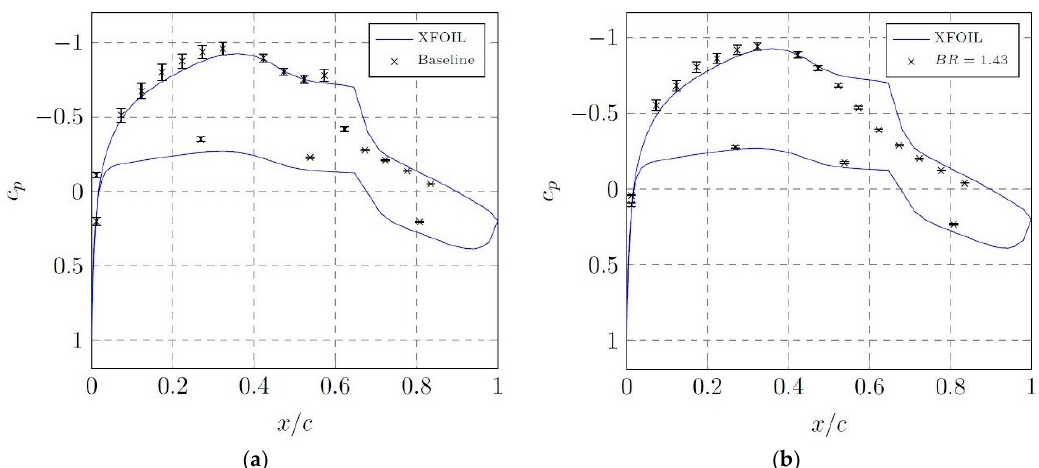
Figure 43. Measured and predicted (XFoil) wall pressure coefficient distributions for Re = 310,000 and α = 0 degrees. ( a ) Uncontrolled flow and ( b ) steady blowing with B = 1.43. (Reprinted from [38]).